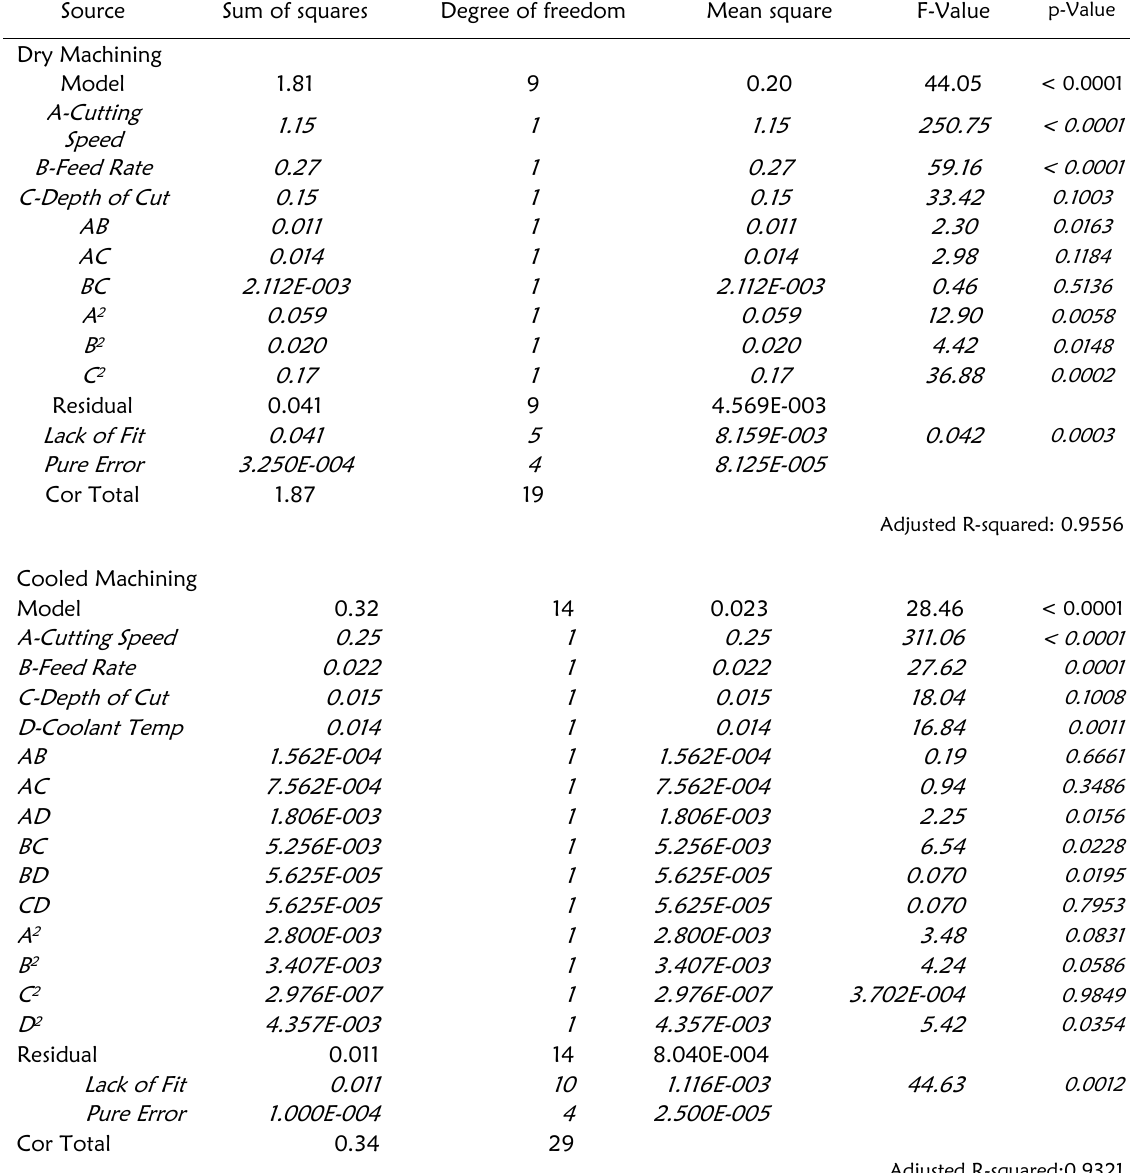
Table 5: Analysis of Variance (ANOVA) for dry and cooled machining